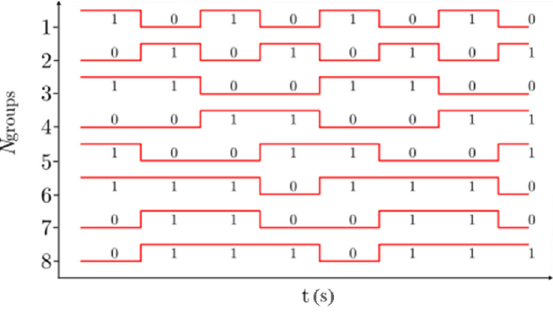
Figure 6. Data bit streams for intensity modulation (IM) of LED groups.